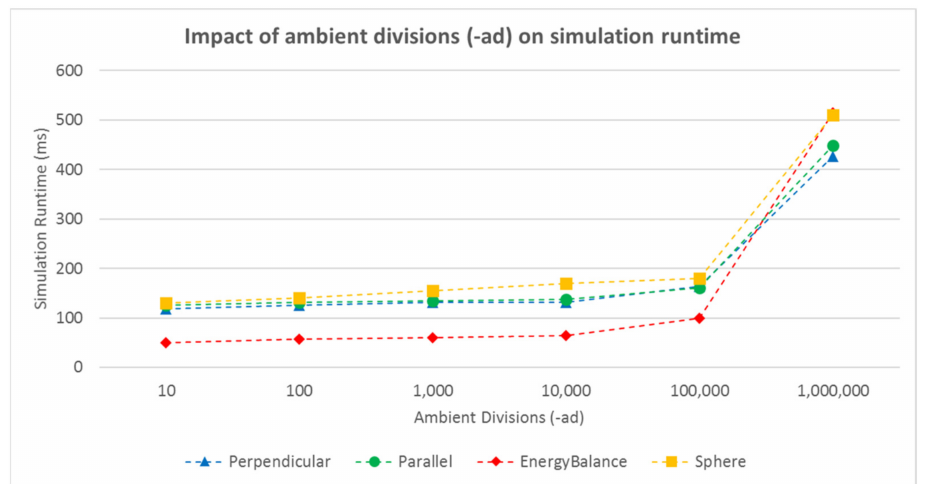
Figure 19. Variation in average calculation runtime according to ambient